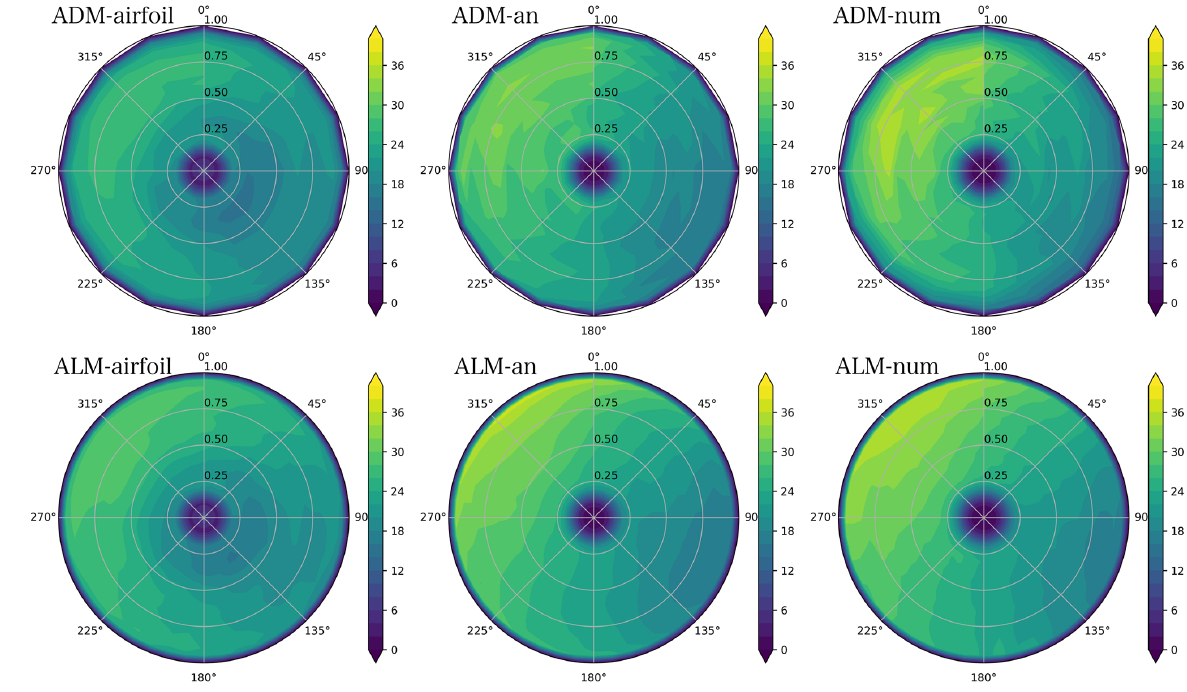
Figure 12. Model comparison for the time-averaged normal force distribution (Nm − 2 ) on the impacted rotor (WT2) for ABL inflow. The wake from WT1 impacts the right side of the rotor plane (Fig. 1).